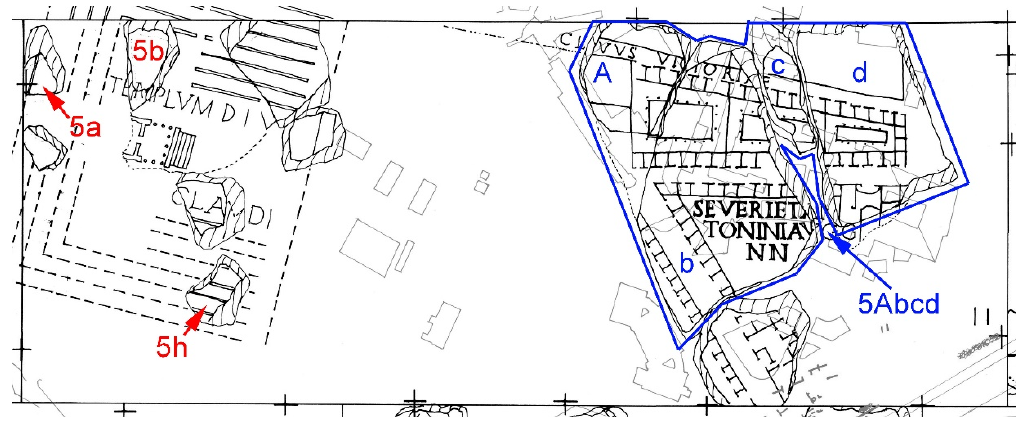
Figure 10. Position of the 5-type fragments within the reconstructed slab IX-5 as appears in [56]. The sampled fragments have been labeled, including the multi-piece 5Abcd fragment and three single-piece fragments (5a, 5b, and 5h). It is well established that these single-piece fragments are part of a representation of the Temple of the Deified Claudius (see Table S2).